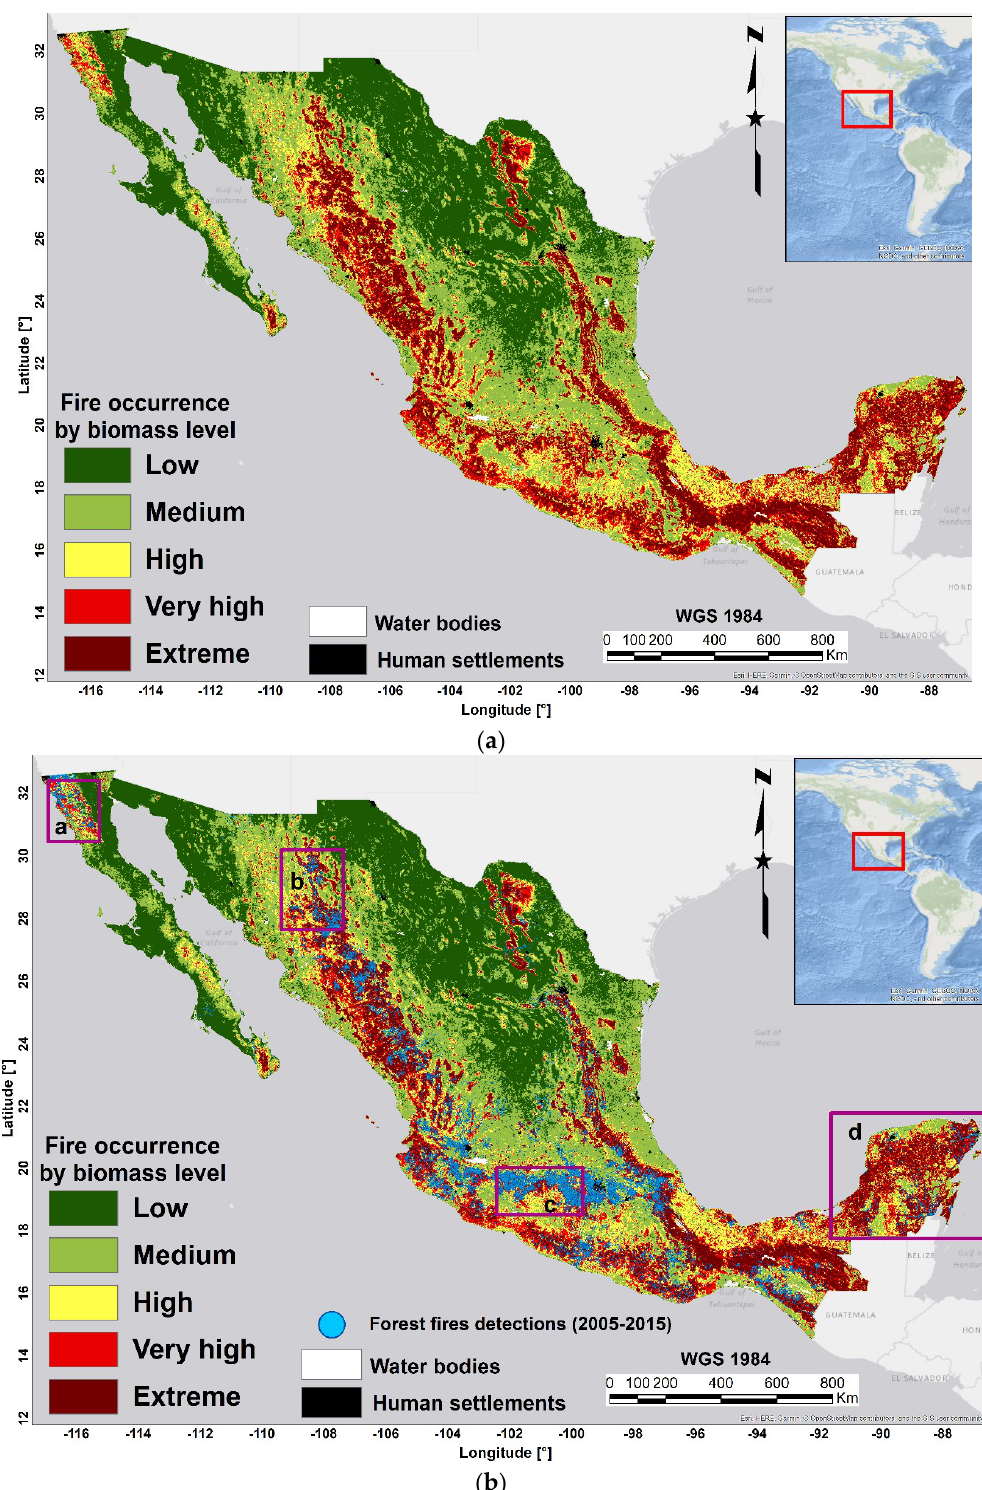
Figure 4. ( a ) Map of normalized fire occurrence by biomass level (FOB N ); where low, medium, high, very high and extreme represent FOB N values of < 1%, 1%–25%, 25%–50%, 50%–75% and > 75% respectively. ( b ) Location of suppressed fires in the study period. The three regional detailed windows included in Figure 4b are analyzed in detail in Figure